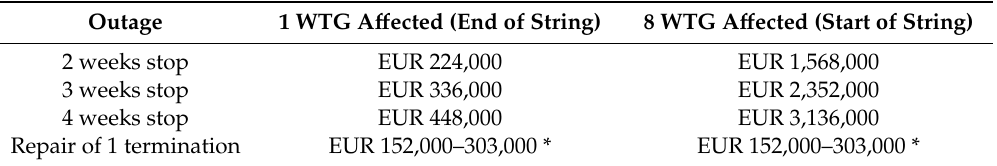
Table 3. Losses of a single inter-array 33 kV or 66 kV termination failures. Approximate failure costs farm with a price of EUR 0.16